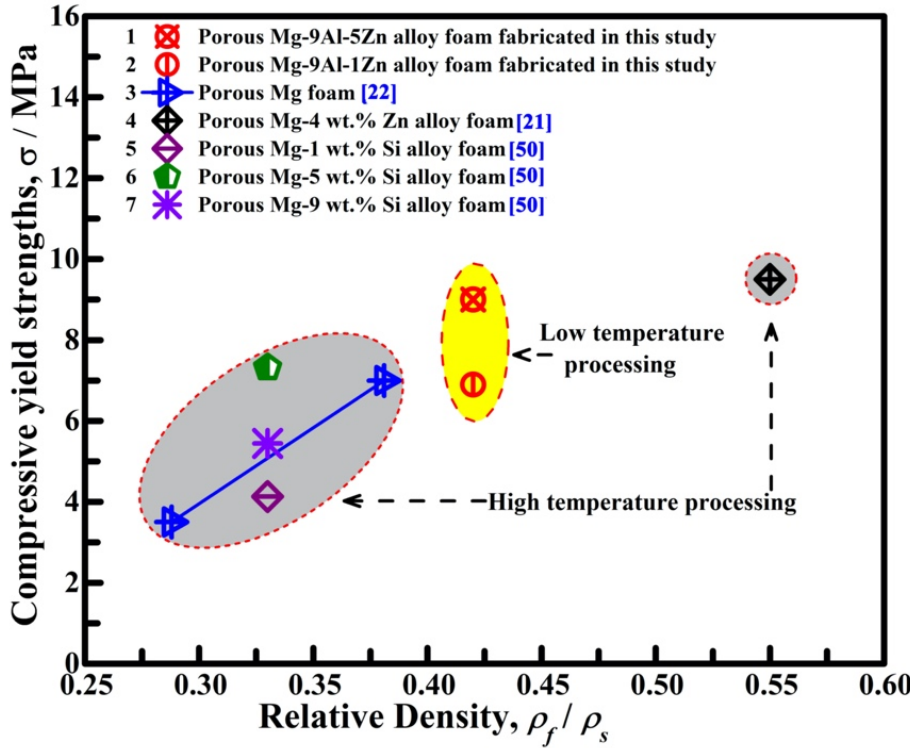
Figure 11. Relationships between the compressive yield strength and relative density of Mg-based foams. In the figure, 1 and 2 are porous Mg alloy foams in this study; 3 is the porous Mg foam data from [22]; 4 is the porous Mg-4 wt. % Zn alloy foam data from [21]; 5, 6 and 7 are Porous Mg-xSi composite foam ( x = 1, 5, and 9 wt.%) data from [50].